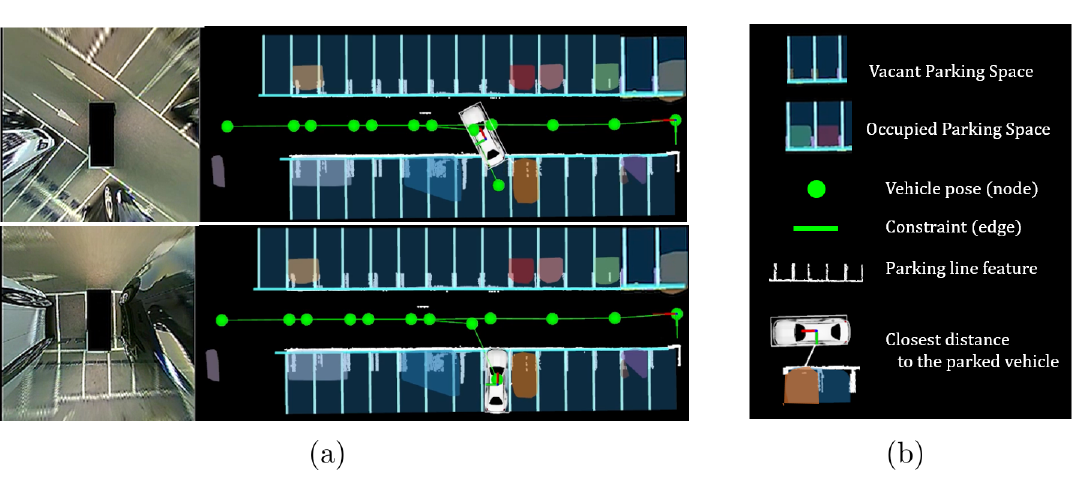
Figure 1. Illustration of the proposed method. The parking line features are extracted from the around view monitor (AVM)/light detection and ranging (LiDAR) sensor fusion data. These are used for both rapid loop closing and detection of parking spaces. ( a ) The left figures show the actual AVM images, and the right figures show the proposed method. ( b ) Graphical explanation of each symbol.